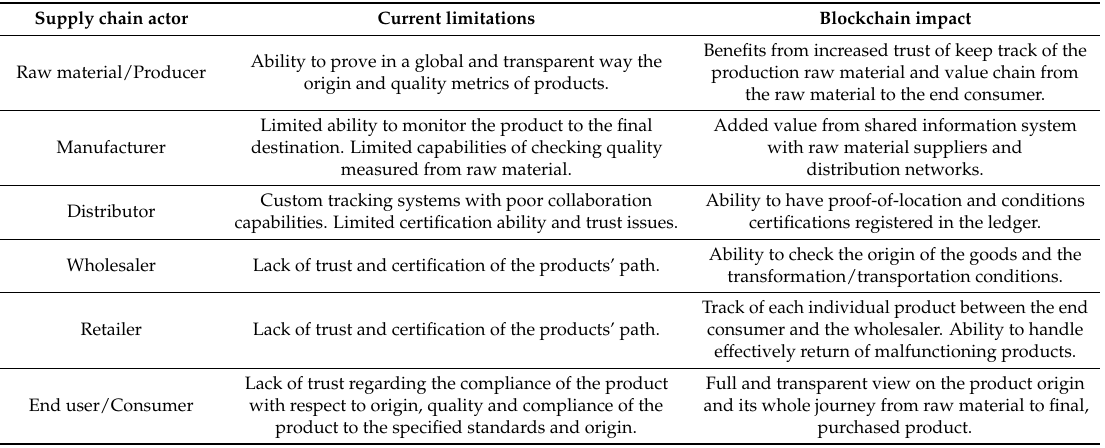
Table 1. Supply Chain actors, current limitations faced and blockchain